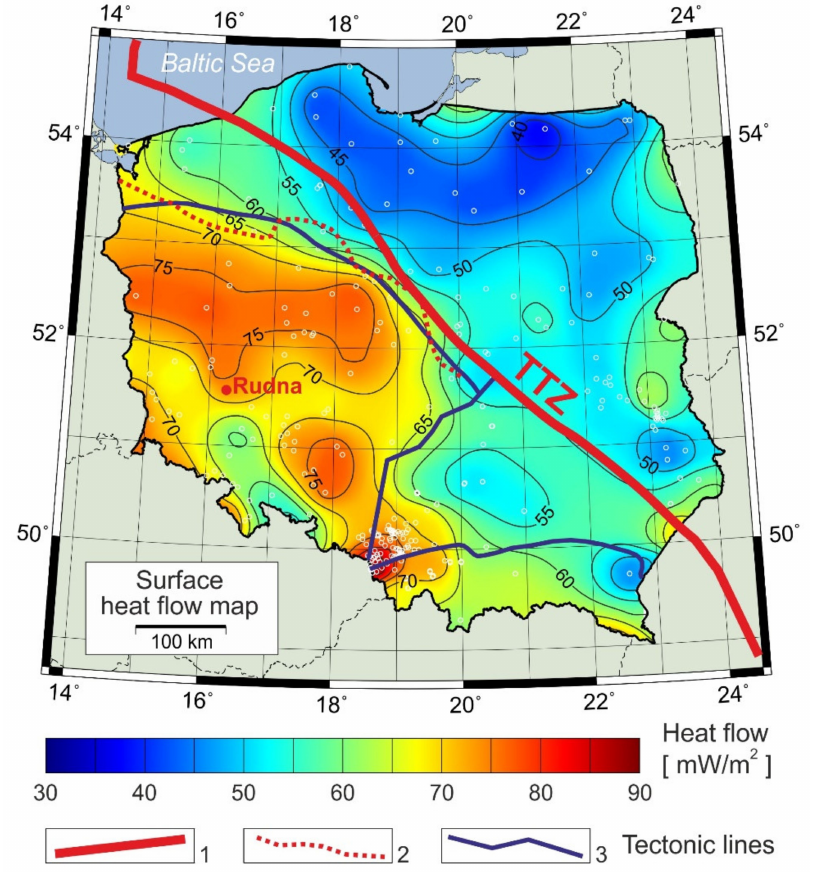
Figure 5. Surface heat flow map of Poland based on heat flow data corrected for paleoclimate according to Majorowicz and Wybraniec [22]. White circles show the distribution of boreholes with heat flow data. Big red dot shows location of the test site Rudna. Note some 20–30 mWm − 2 difference in average heat flow magnitudes between this map and the map in Figure